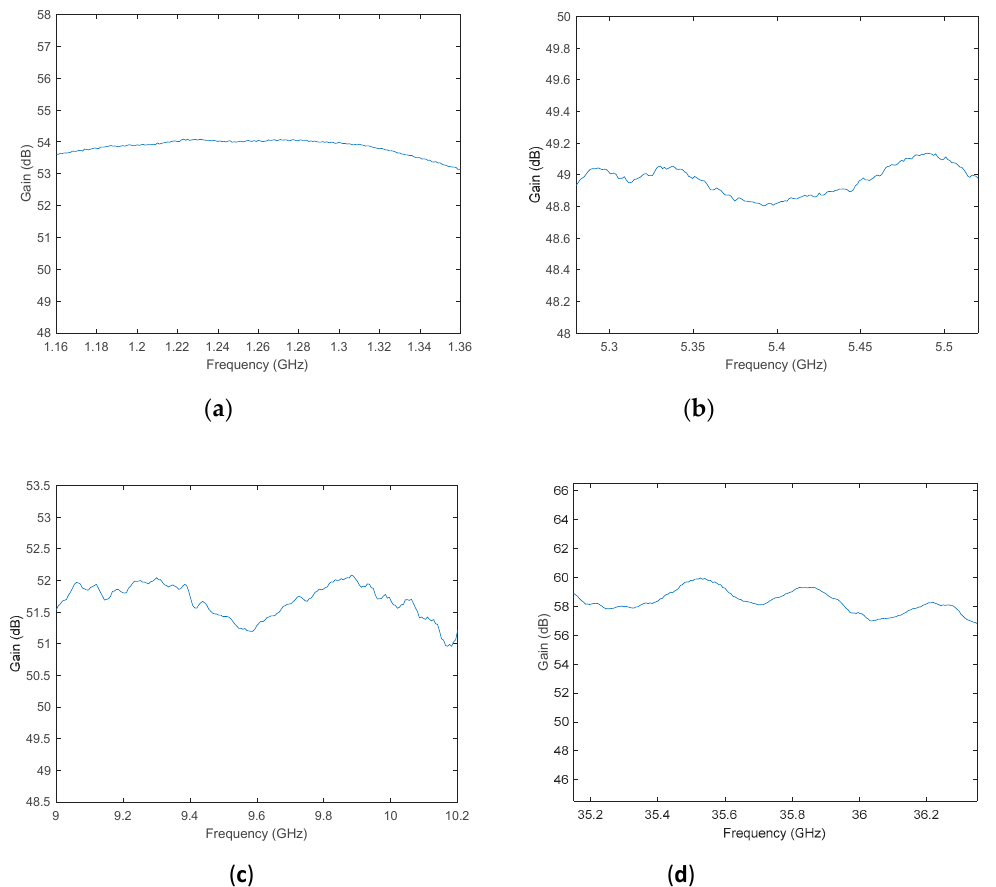
Figure 13. The gain flatness: ( a ) L-band; ( b ) C-band; ( c ) X-band; ( d ) Ka-band.